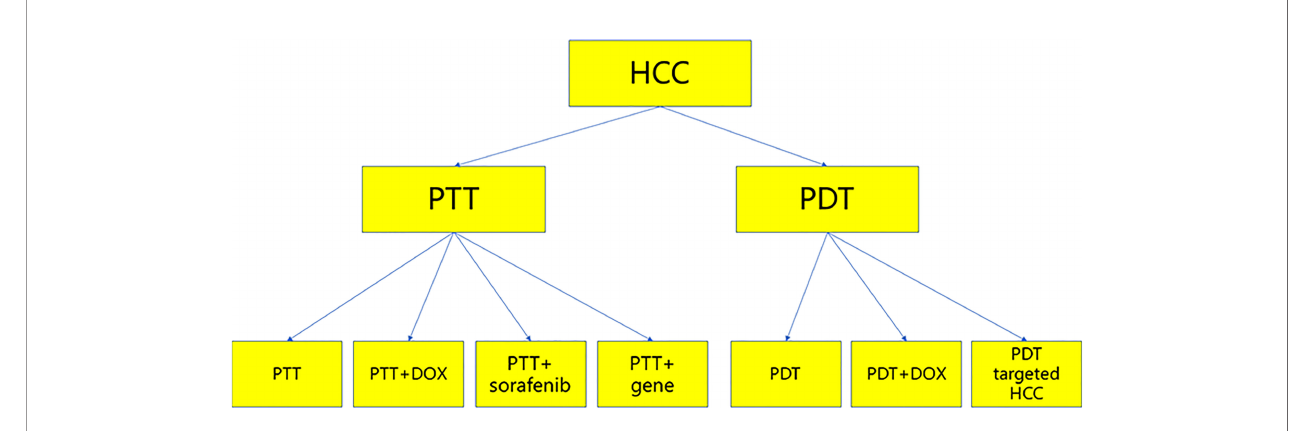
FIGURE 2 | The summary charts.